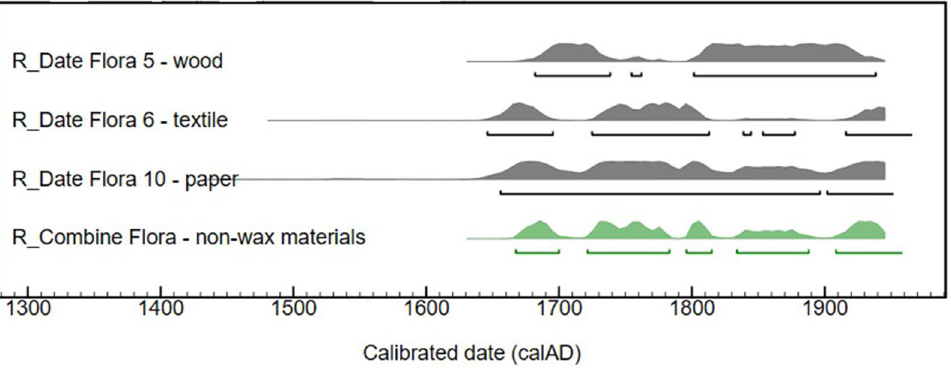
Figure 4. Calibrated 14 C dates for wood, textile and paper samples taken from the Flora bust (in grey). The statistical combination of the three dates in green gives the interval of 1667–1950 AD. The χ 2 test value of T = 4.1 (5% 6.0) shows their